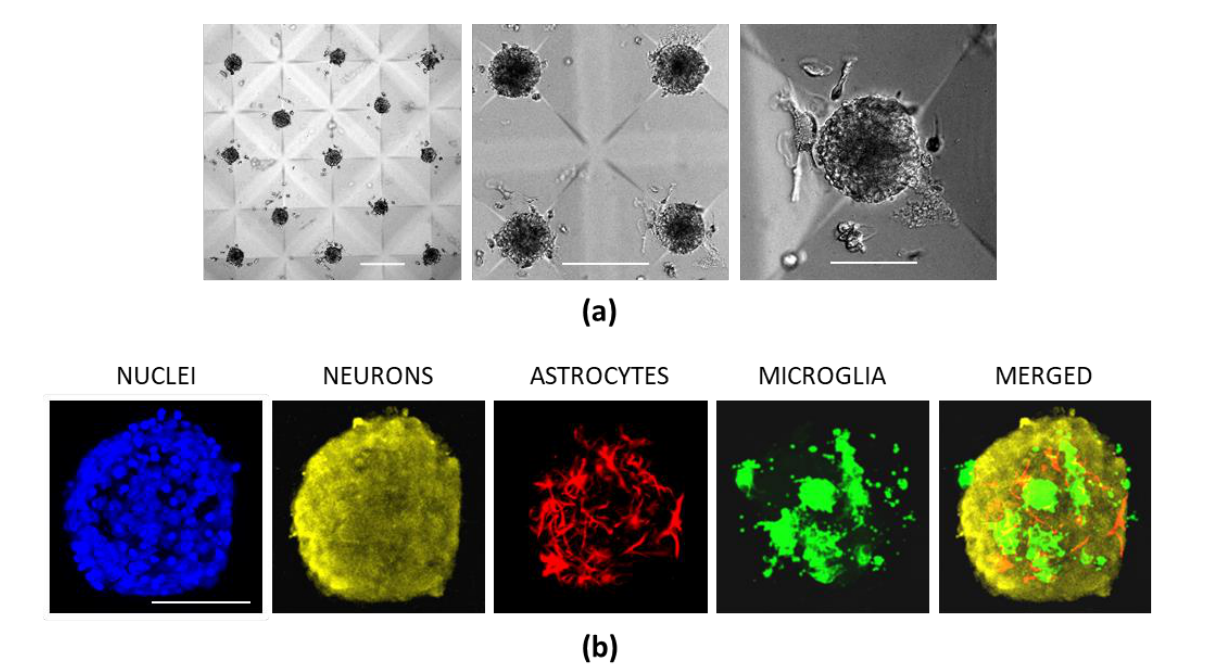
Figure 8. Cerebellar neuronal-glial organoids in microwells fabricated in CLP-PEG hydrogel blocks during seven days in culture. In ( a ), images of living cells in organoids were taken under a brightfield microscope. In ( b ), micrographs of immunostained cells in fixed organoids. Hoechst 33342-stained nuclei are blue, neurons (yellow) are immunolabelled with anti-MAP2; astrocytes (red) with anti-GFAP and microglia are stained green with isolectin GS-IB 4 . The MERGED image is presented without NUCLEI. The scale bar in both ( a ) and ( b ) panels is 50 μ m.